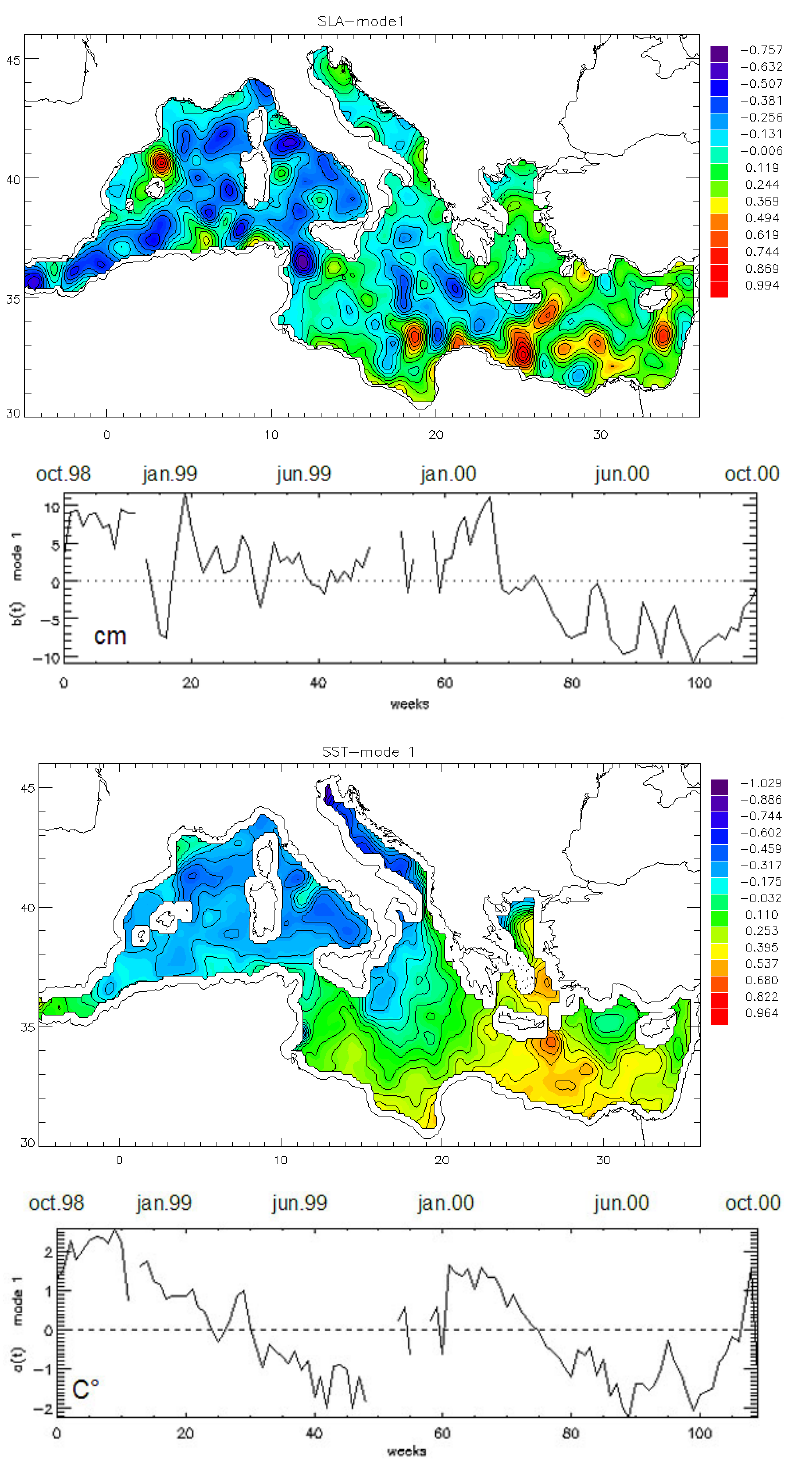
Fig. 5. First coupled mode of SLA and SSTA data collected during MFSPP after removing the spatial averages over the basin (“gradient CPA”). Patterns and associated temporal coefficients: (a) SLA pattern, (b) SLA temporal coefficient, (c) SST pattern, (d) SST temporal